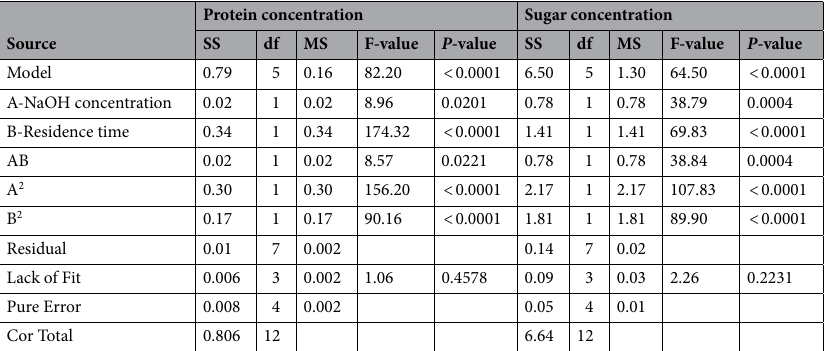
Table 3. Analysis of variance (ANOVA) for the response surface quadratic model of MAH of DSM-JP on protein and sugar concentration of hydrolysate. SS sum of squares, df degree of freedom, MS mean square. Protein concentration: R 2 = 0.9833, R 2 adj = 0.9713, R 2 pred = 0.9326, adequate precision = 22.8576. Sugar concentration: R 2 = 0.9788, R 2 adj = 0.9636, R 2 pred = 0.8926, adequate precision =